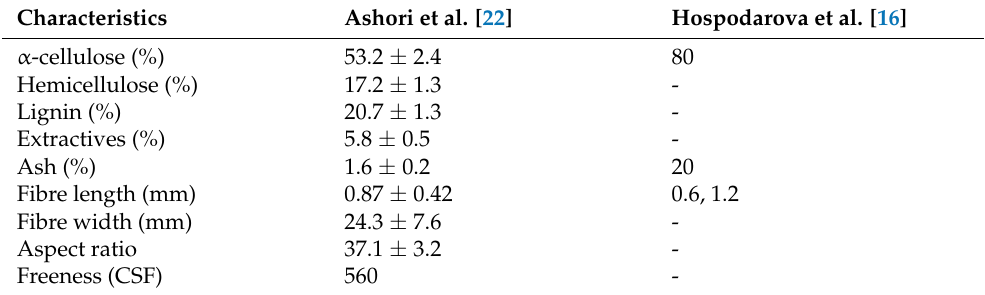
Table 2. Chemical and morphological properties of recycled paper fibres [16,22]. Characteristics